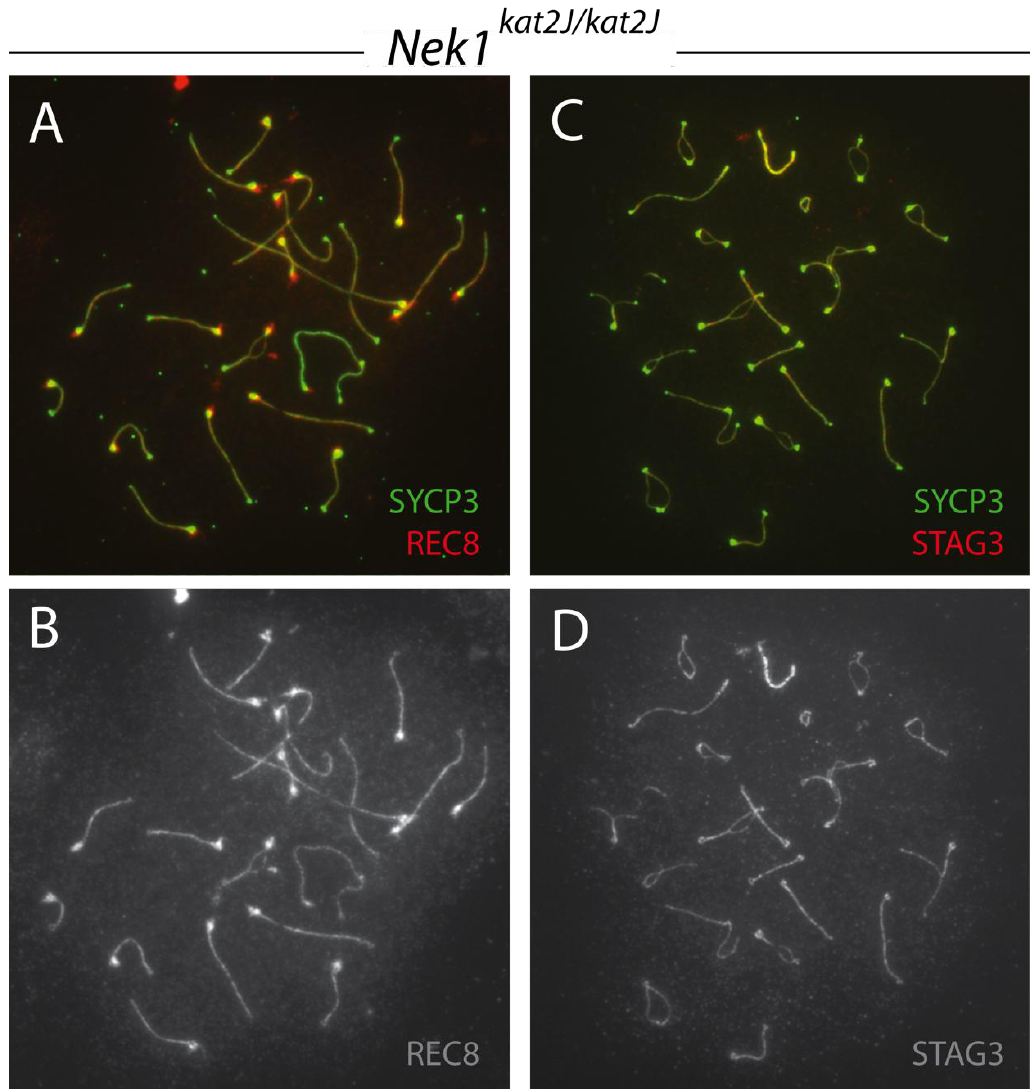
Figure 8. REC8 and STAG3 cohesin localization in Nek1 kat2J/kat2J spermatocytes. Nek1 kat2J/kat2J prophase I spermatocytes were stained with anti-SYCP3 (green) and either anti-REC8 (A, B), or anti-STAG3 (C, D) (red or gray).